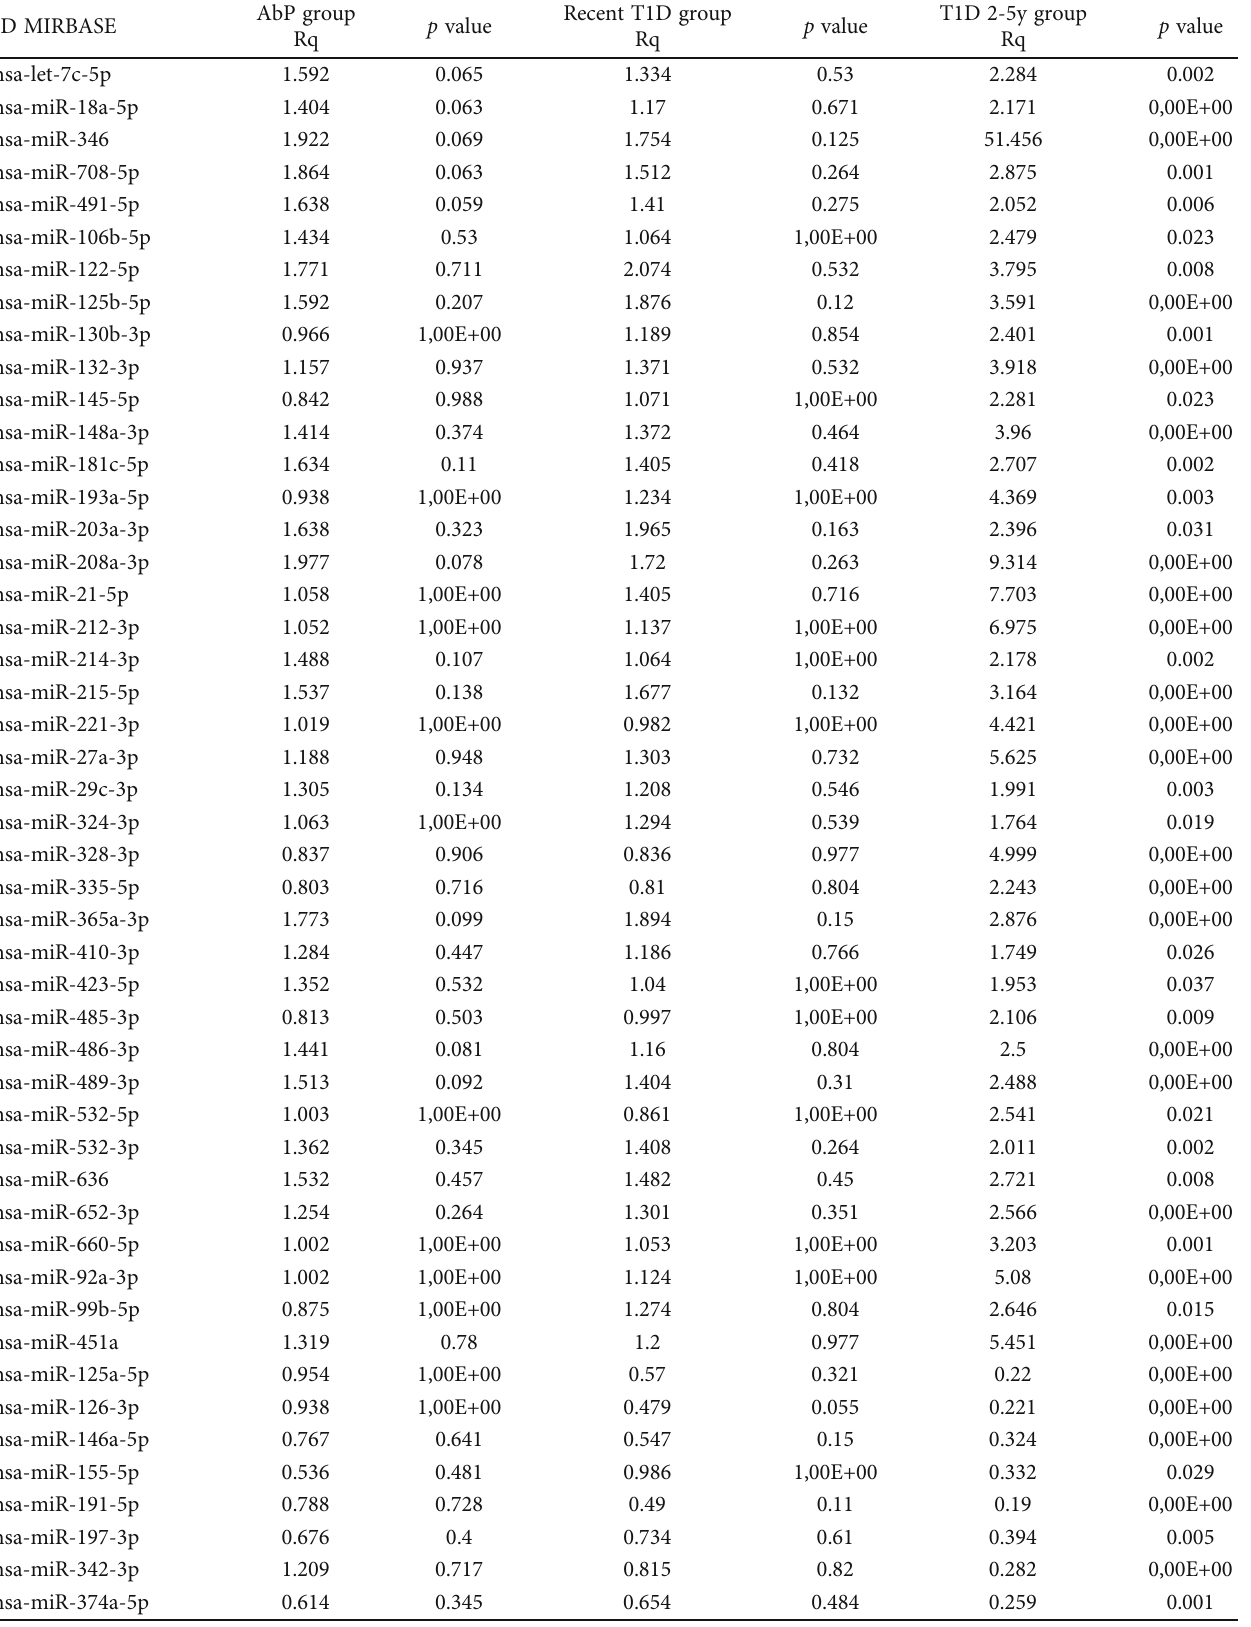
Table 3: MicroRNA expression pro fi le of cluster B in comparison to the control